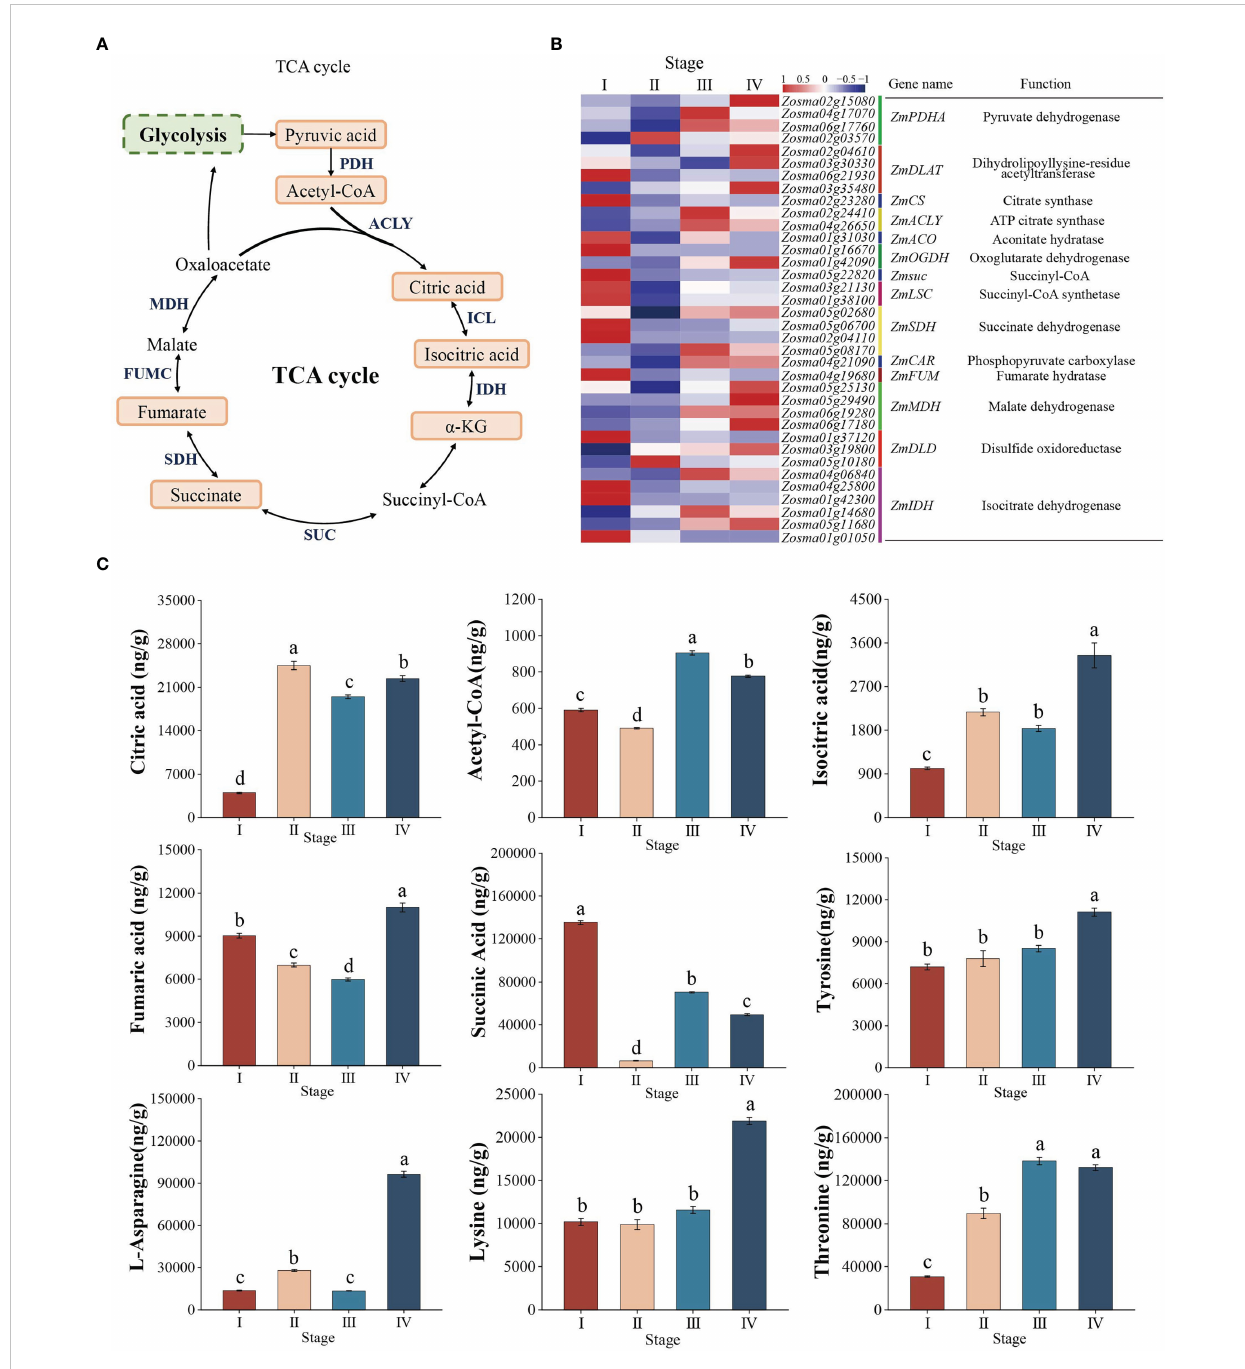
FIGURE 7 TCA cycle. (A) Model and key components of the TCA cycle in Zostera marina seeds. The highlighted boxes indicate the metabolites quanti fi ed from the LC – MS/MS results. (B) Heatmap analysis of DEGs (log 10 (FPKM) values) involved in the TCA cycle. (C) Analysis of changes in the represented metabolites in the TCA cycle during Zostera marina seed